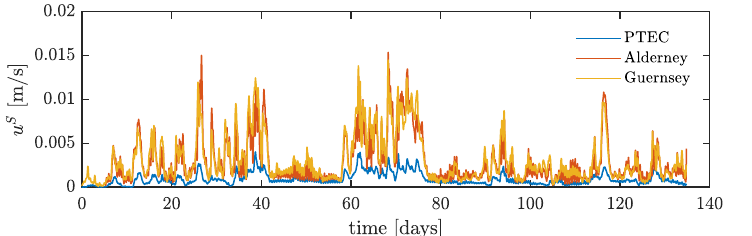
Figure 9. Depth-averaged Stokes drift current speeds derived from the wave model for the three sites.